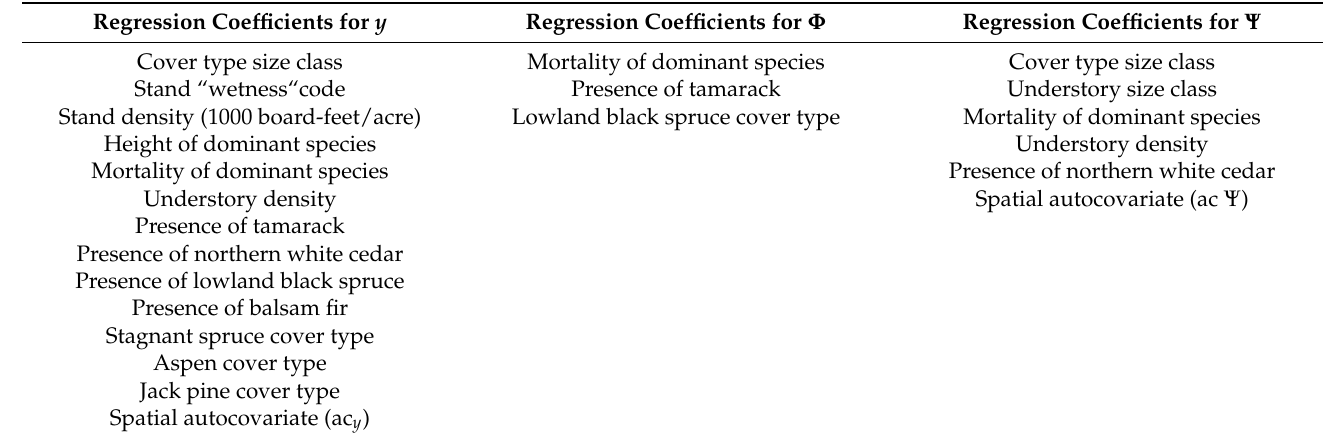
Table 1. Variables included in the Bayesian data reconciliation model used to predict occurrence of ESDM; for full model description see Hanks et al.